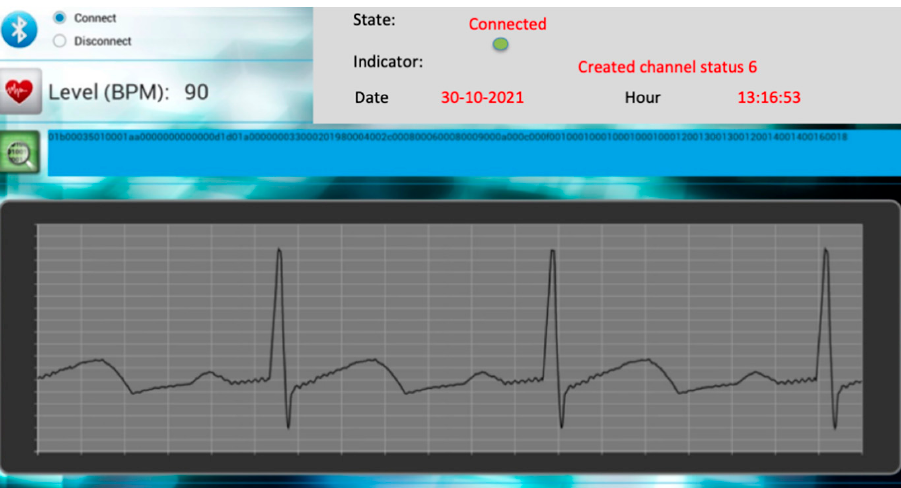
Figure 6. Graphical user interface of the ECG Android application, in which the Bluetooth connec ‐ tion status, the date and hour, heart rate, and ECG waveform are shown.